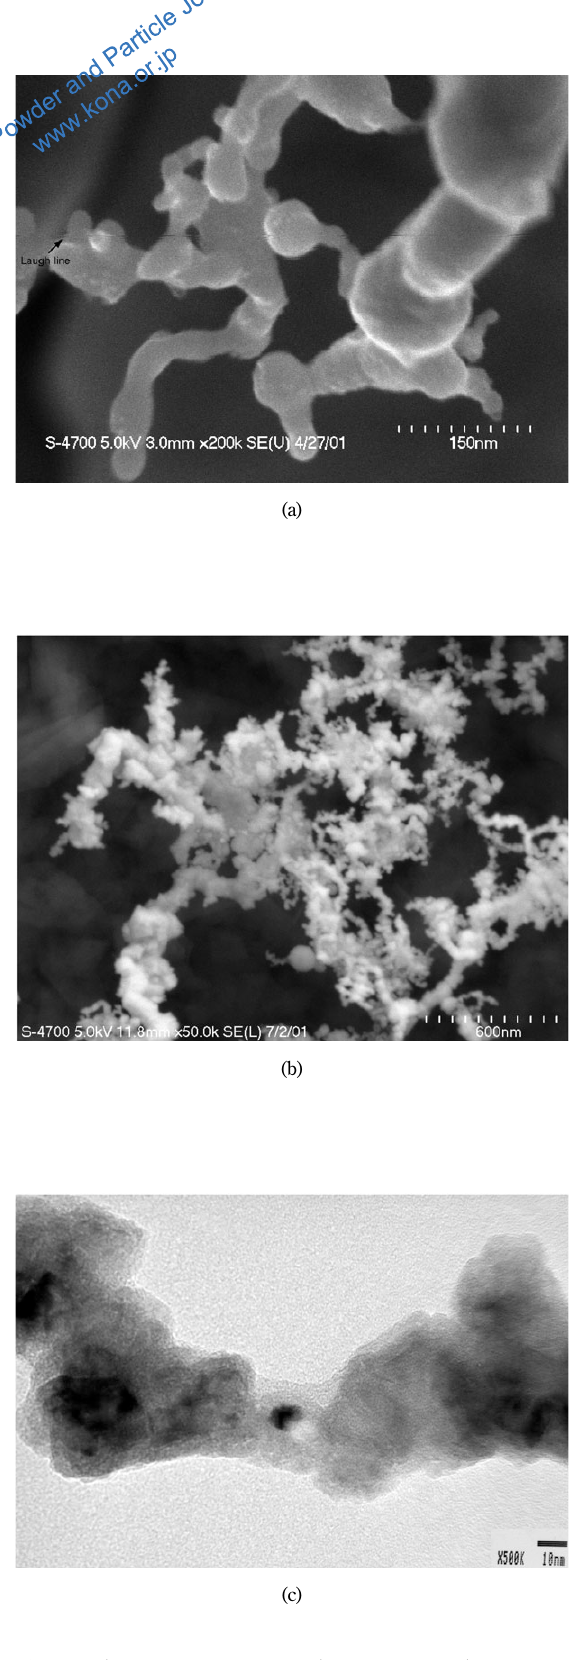
Fig. 1 Electron microscopy of the Fe nanopowder. FESEM images show in (a) the individual nanometer-sized parti- cles, and in (b) the dendritic agglomerates. Bright field TEM image of the particle substructure is shown in (c). Fig. 2 Type II BET surface area isotherm of the nanosized